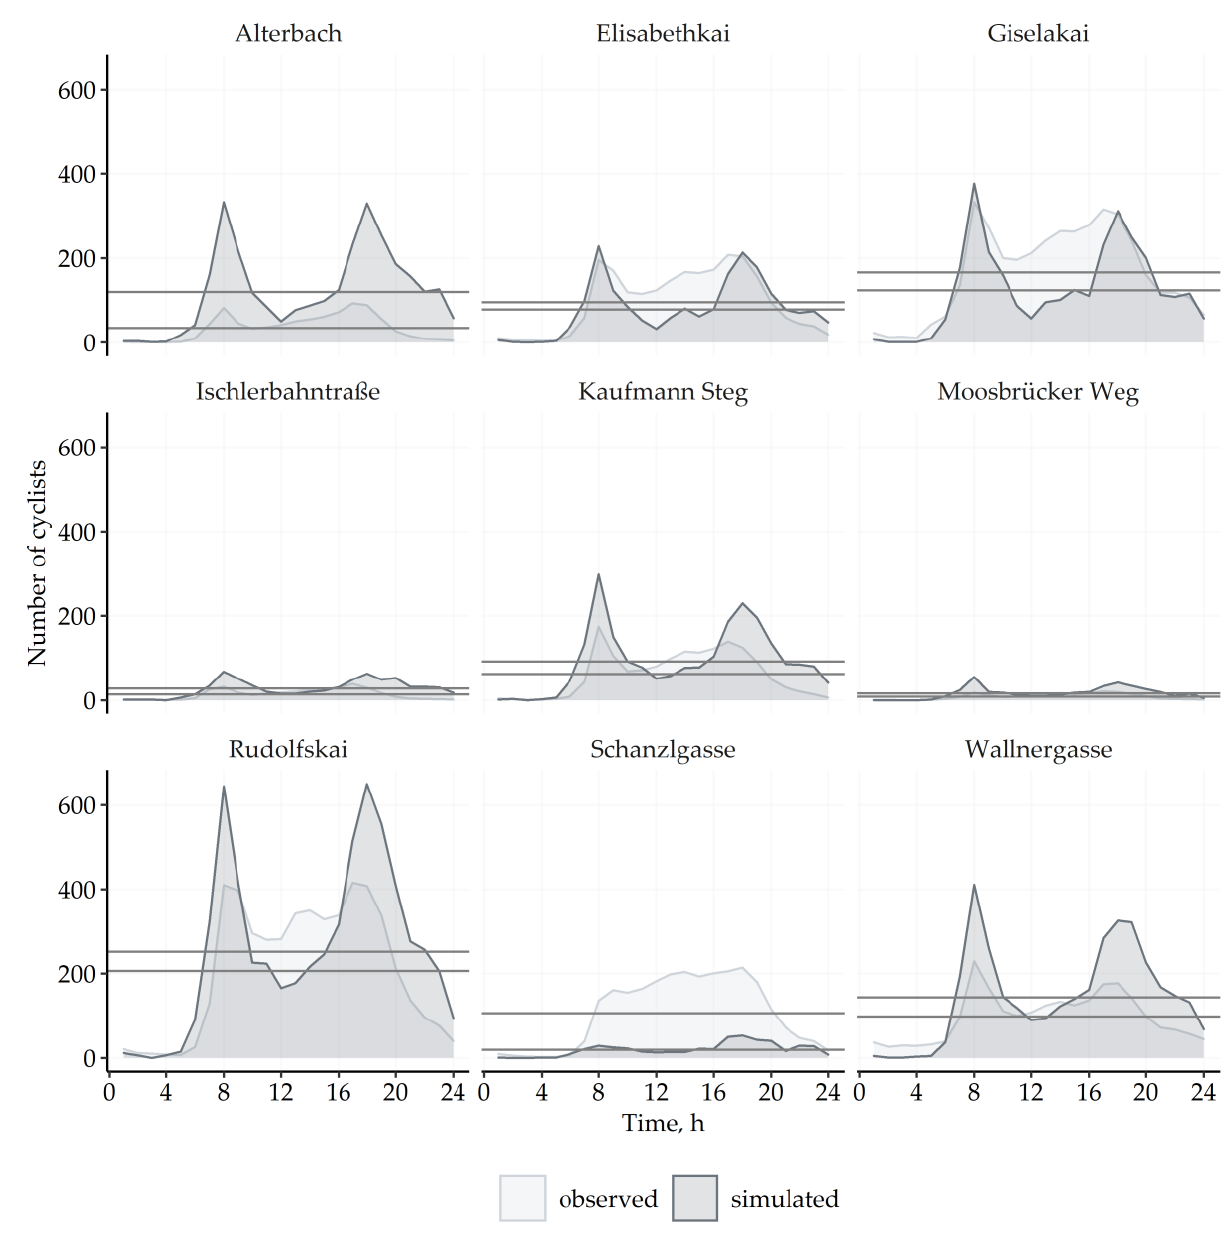
Figure 3. The temporal distribution of traversed cyclists at stations by an hour; grey links represent the mean numbers of traverses in simulated results and observed data. Table 5. The ratios of traversed cyclists at stations during the morning peak vs. afternoon peak.